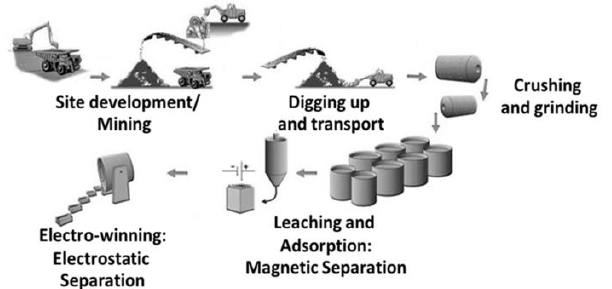
Fig. 4. Flow diagram of gold ore processing (Modified from [17]).